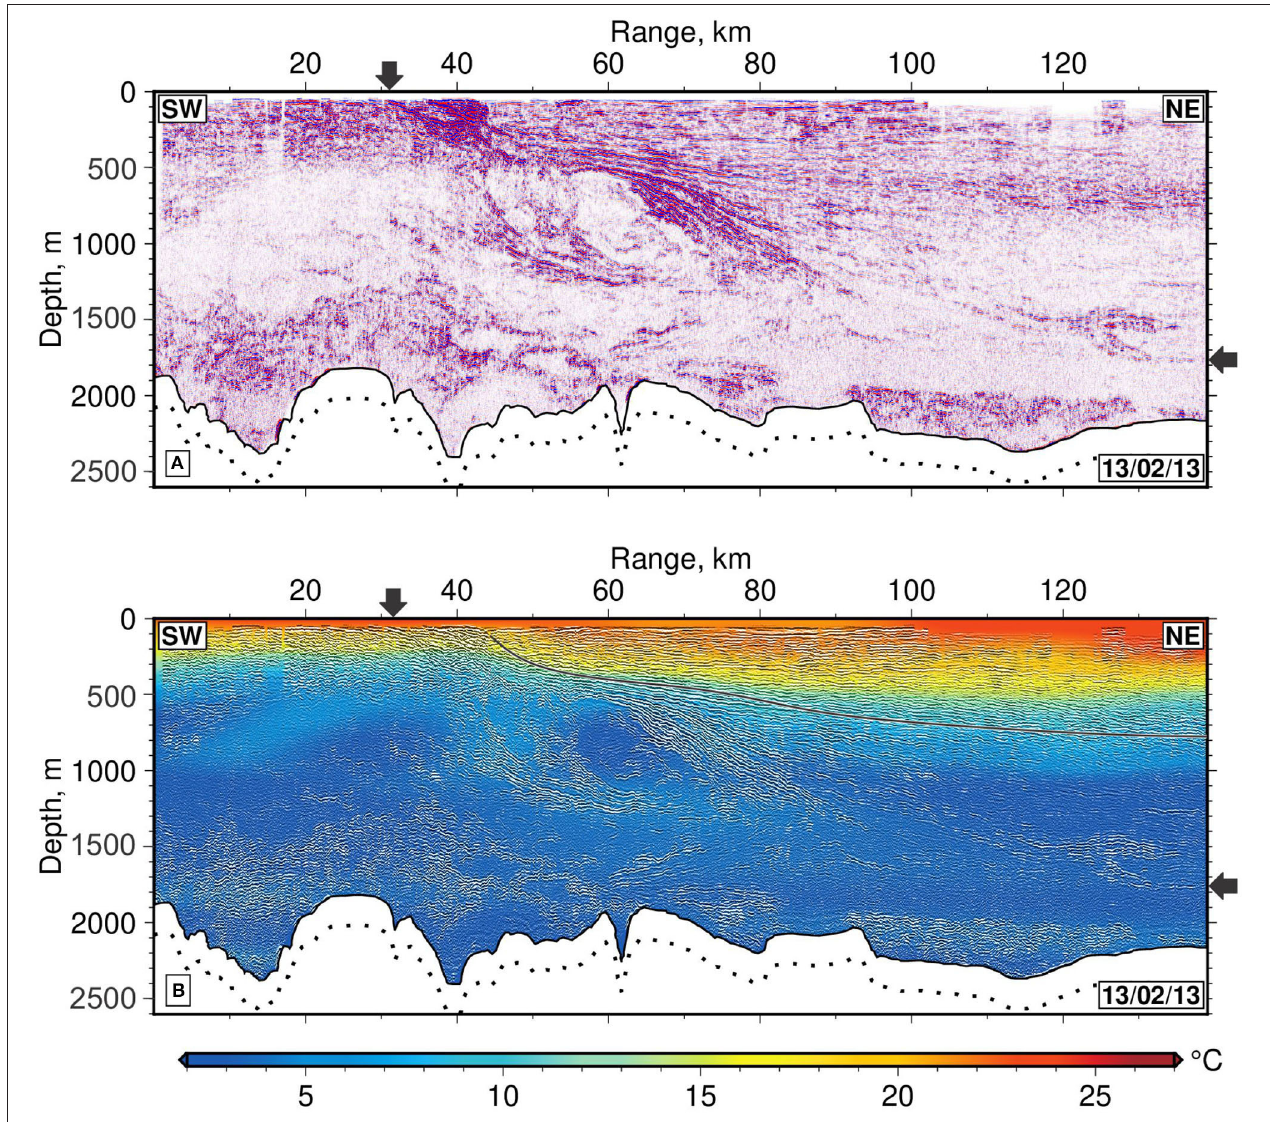
FIGURE 4 | (A) Seismic reflection section B that crosses oceanic front (see also Figure 1C and panel dated 13/02/13 of Figure 3 ). Red/blue stripes represent positive/negative polarity reflections generated by temperature changes as small as ∼ 0.01 ◦ C within water column; irregular solid/dotted lines = seabed; black arrows = maximal extent of front at sea surface and at depth. (B) Corresponding conservative temperature field calculated using iterative inversion procedure (Gunn et al., 2018, 2020). Warm/cool colors = temperatures according to scale bar; solid black line = smoothed potential density anomaly contour of 26.8 kg m − 3 which highlights shallowest sub-surface expression of front (see Figures 3 , 8E,F of Gunn et al., 2020 for more detailed